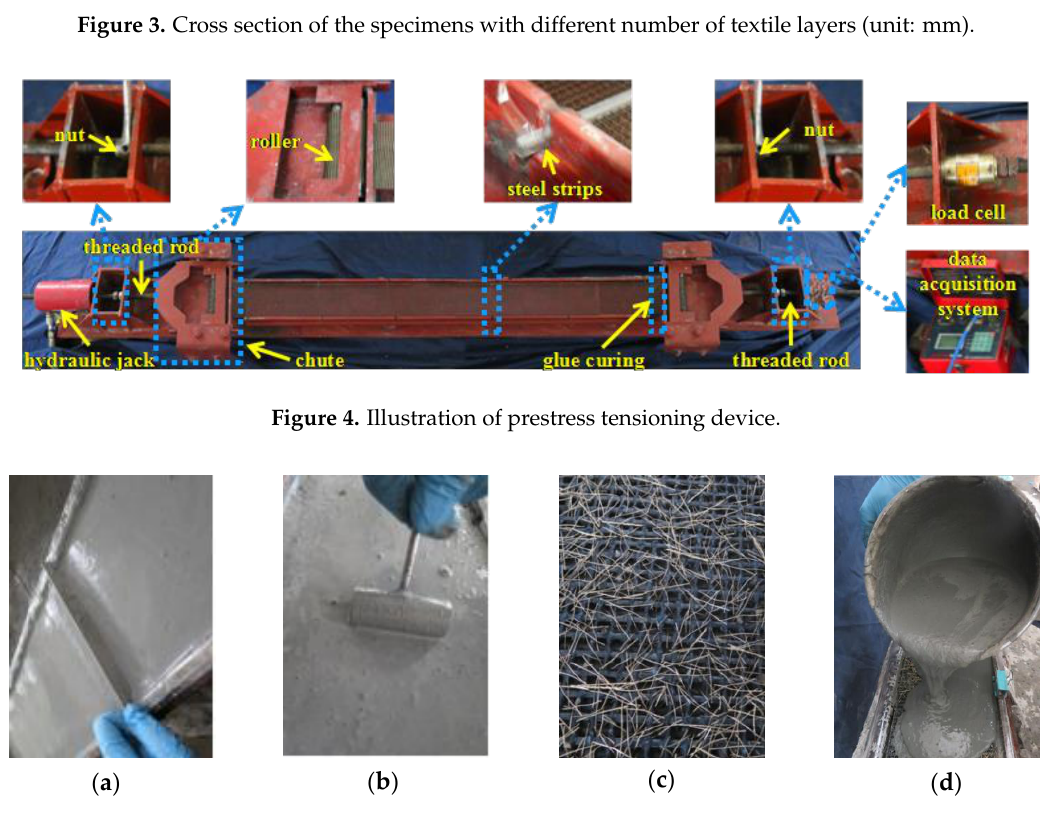
Figure 5. Preparation of the plates: ( a ) levelling the surface; ( b ) smoothing the surface; ( c ) steel fibres inserted in the grids; and ( d ) steel fibres mixed with the matrix.